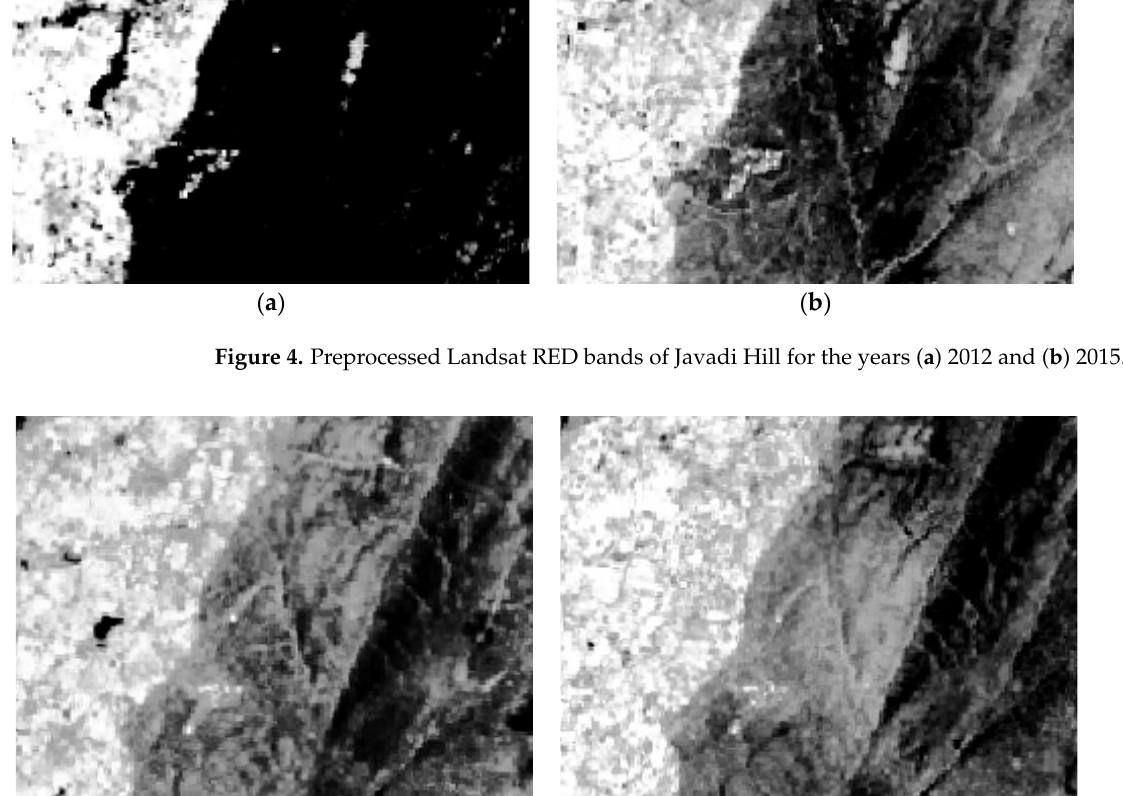
Figure 5. Preprocessed Landsat NIR bands of Javadi Hill for the years ( a ) 2012 and ( b ) 2015.